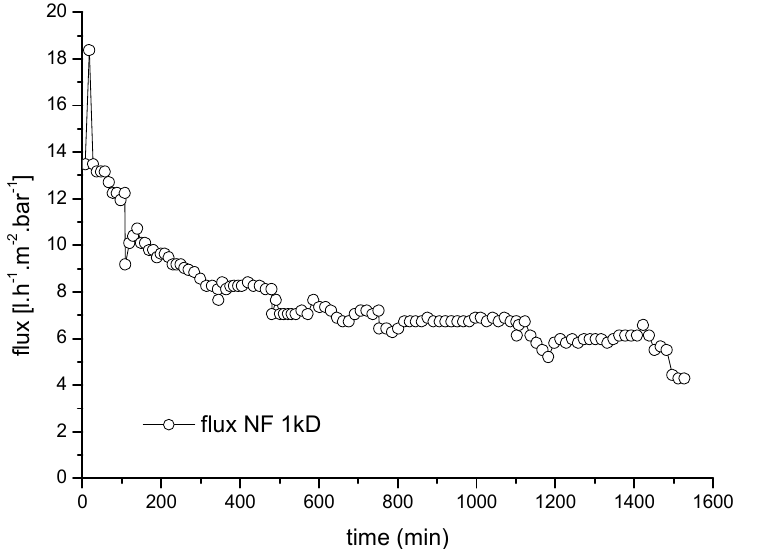
Figure 11. Normalized average flux rate and flux degradation for a 1-kDa ceramic NF membrane (second stage) with the permeate from an upstream UF membrane as the feed solution. CFV = 3.2 × 10 − 5 m·s − 1 ; temperature = 60 °C; TMP = 2.0